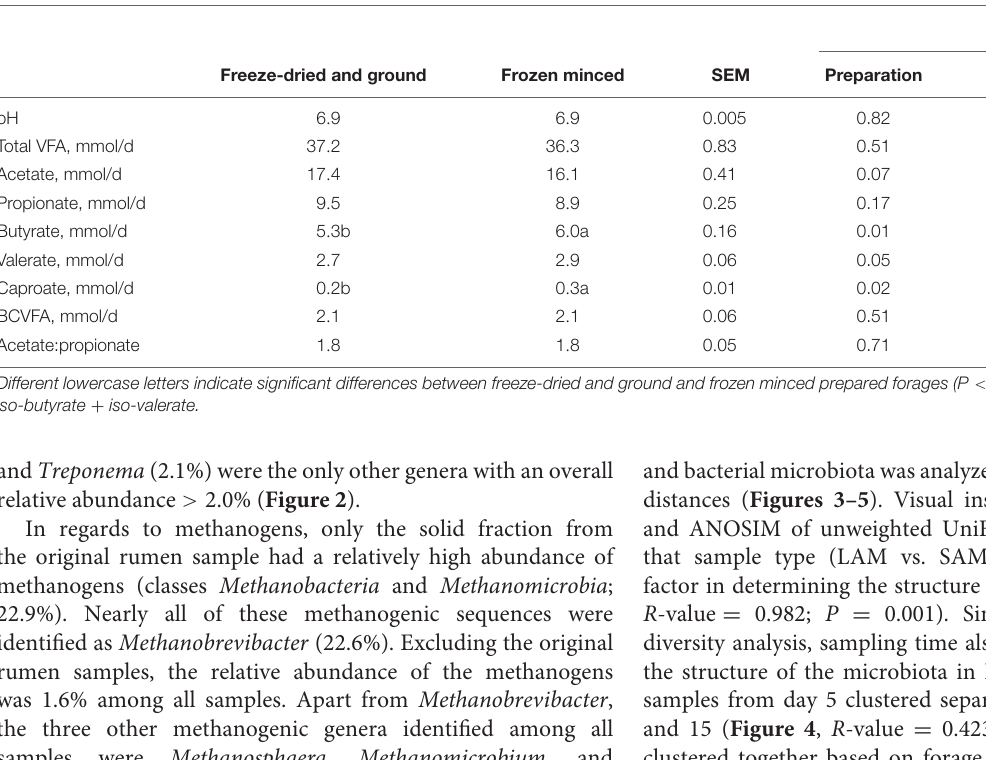
TABLE 2 | Effect of forage preparation on pH and volatile fatty acids (VFA)